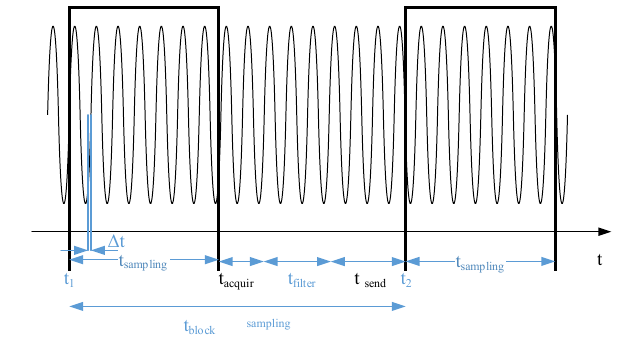
Figure 9. Detailed processing time division of analog signals.